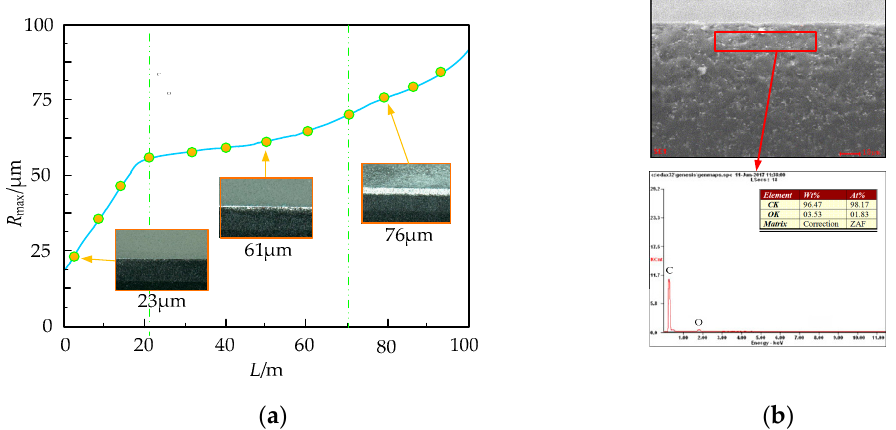
Figure 4. Tool wear law and mechanism: ( a ) Variation law of R max due to various milling length; ( b ) EDS analysis of the wear area, when the milling length is 81m.